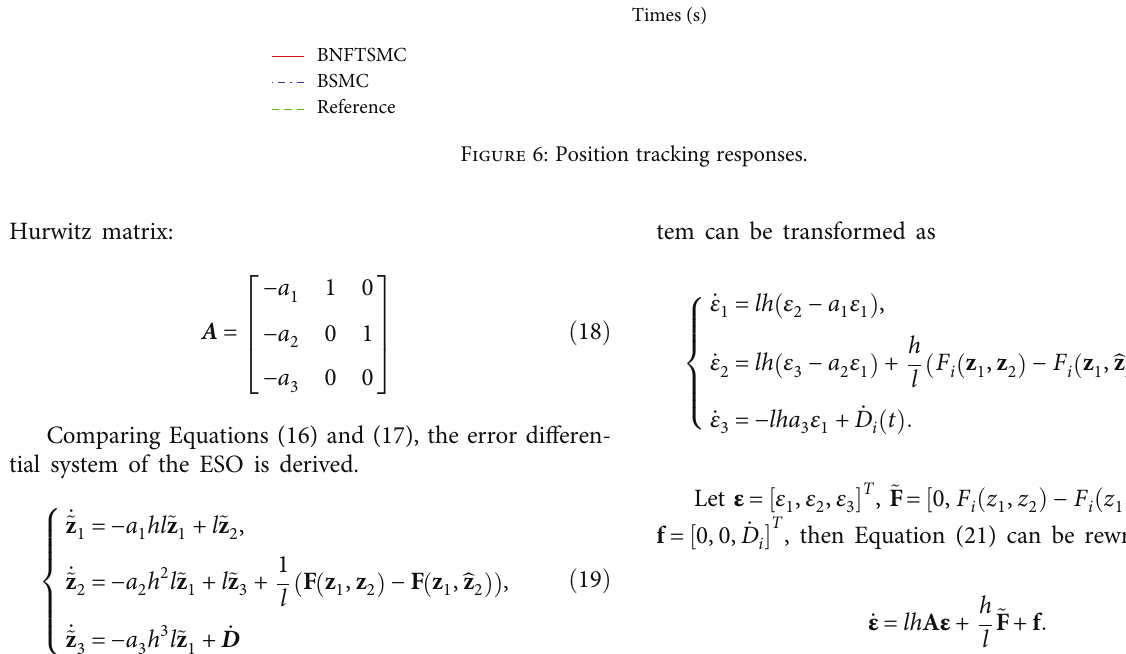
Figure 6: Position tracking